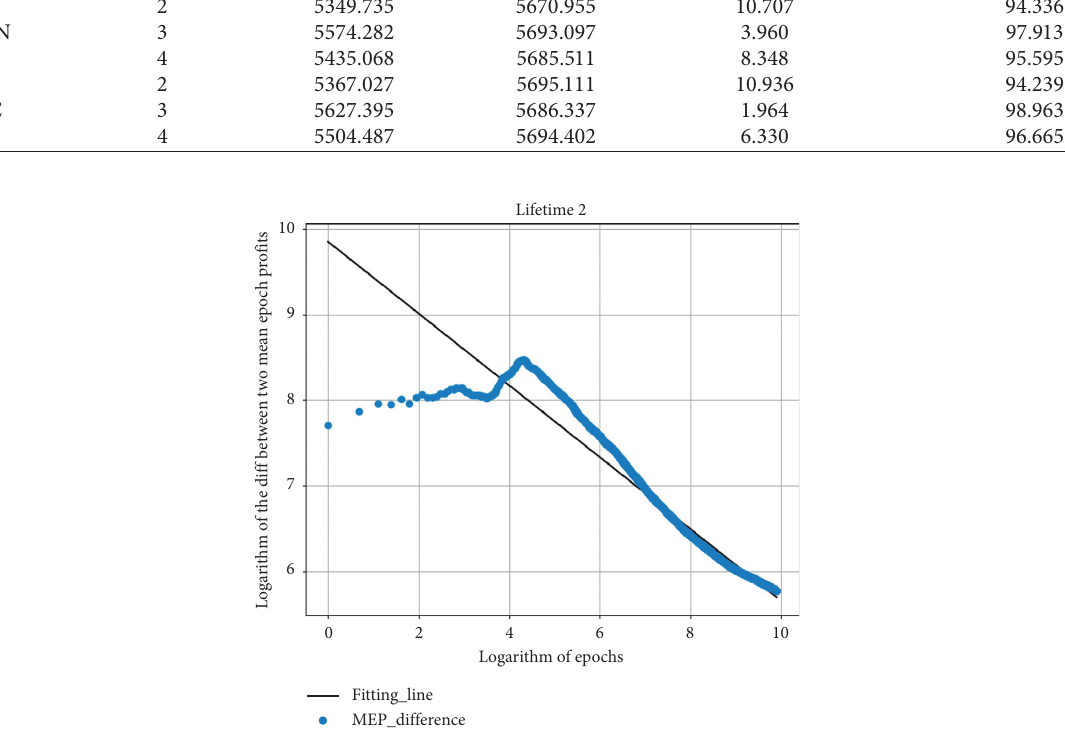
Figure 9: Log-log scale MEP difference for lifetime 2.